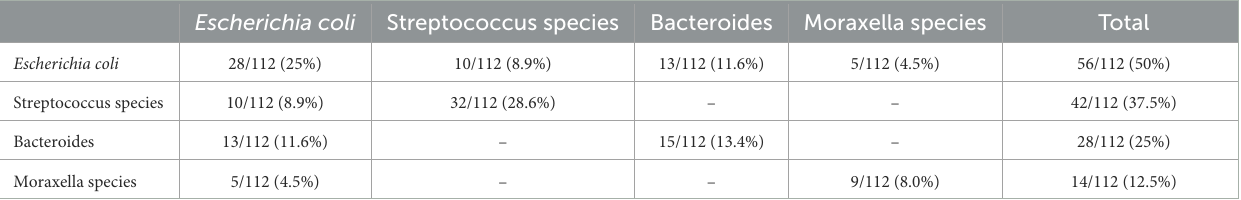
TABLE 1 Results of microbiological examination performed on genital swabs collected from dromedary camels with endometritis and a history of conception failure.